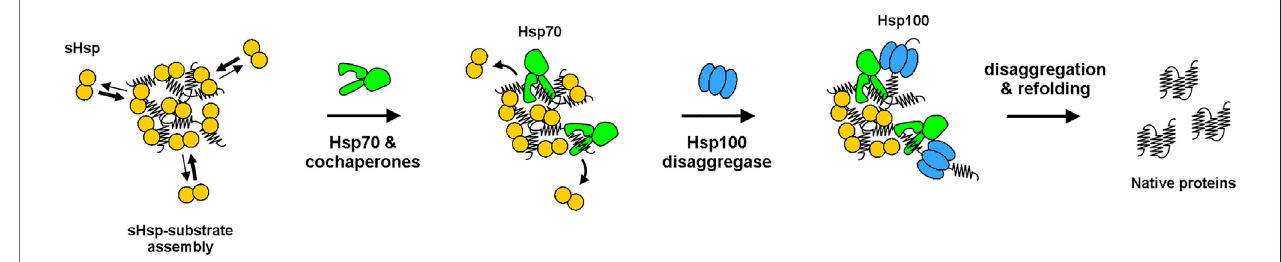
FIGURE 2 | Model of refolding of substrates from sHsp – substrate assemblies by Hsp100-Hsp70 bi-chaperone system. sHsps dynamically bind and dissociate from the assemblies, competing with Hsp70 for binding sites. Binding of Hsp70 to assemblies allows for Hsp100 (ClpB) disaggregase recruitment, which initiates substrate disaggregation and